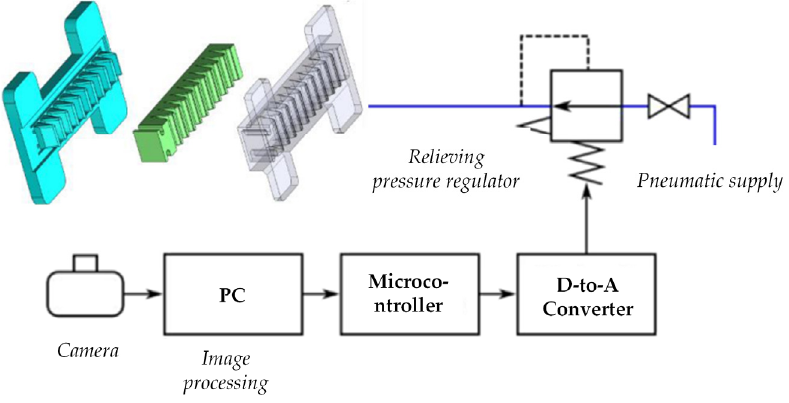
Figure 5. System diagram of the finger actuator .